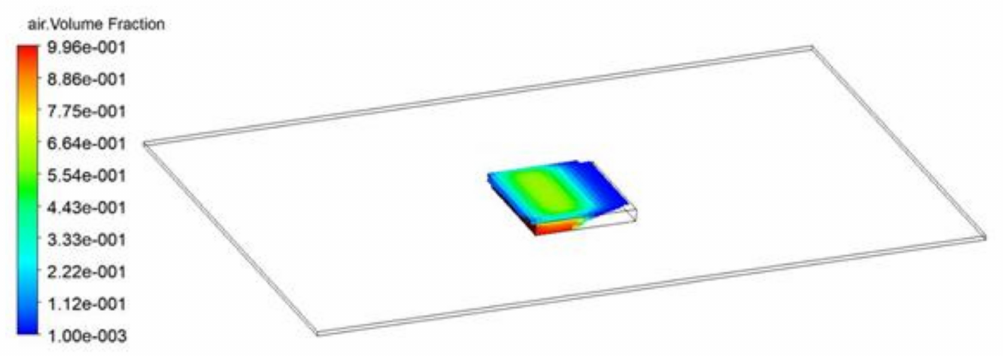
Figure 8. The air volume fraction is generated by a square dimple with side of 75 µ m and depth 10 µ m. Gap 3 µ m, sliding velocity 5 m / s. The volumes of the mesh where the volume fraction of air is greater than 1% (cid:24) are